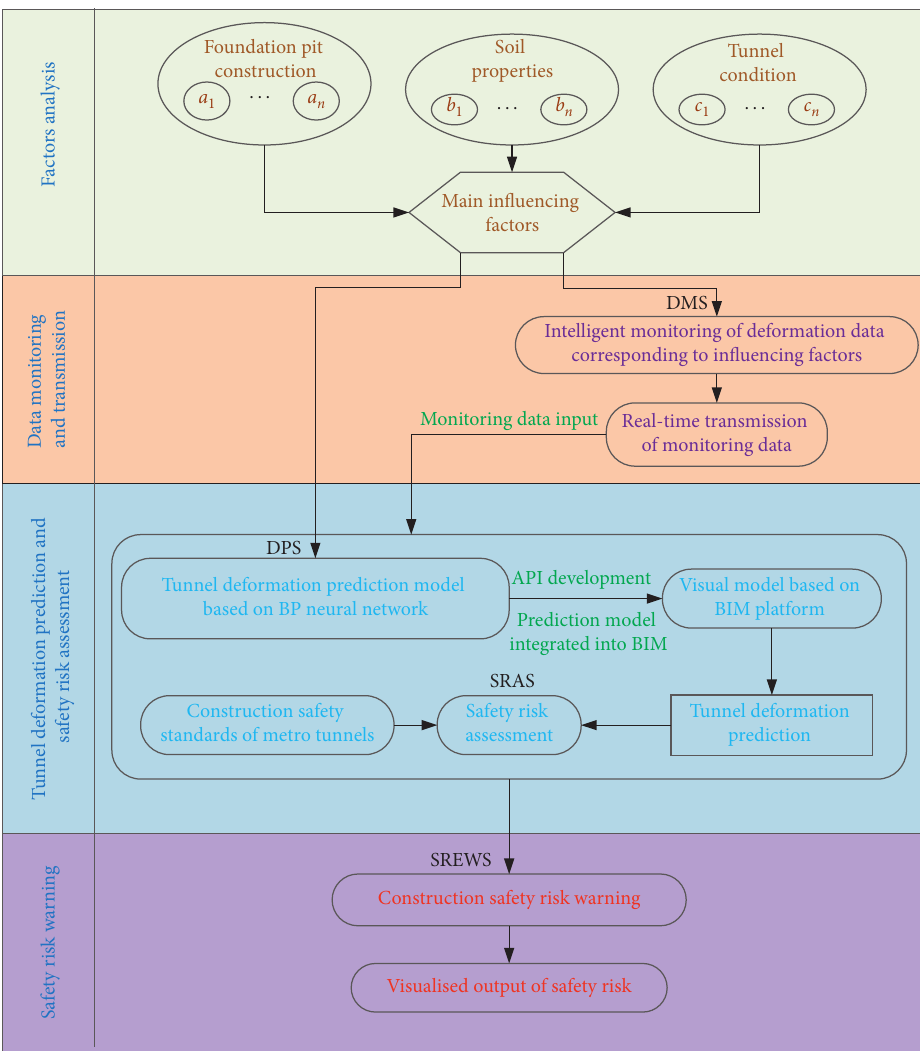
Figure 1: Intelligent early warning system